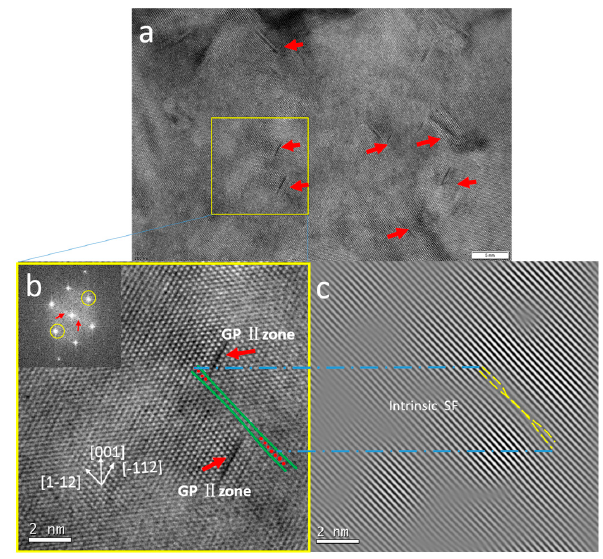
Figure 3. HREM images of rolled 7075 Al alloys after aging at 70 °C for 175 h: ( a ) HREM image; ( b ) the magnified picture of the yellow square in ( a ) shows an intrinsic stacking fault between two GP II zones; ( c ) IFFT shows one drawn-out (111) plane.